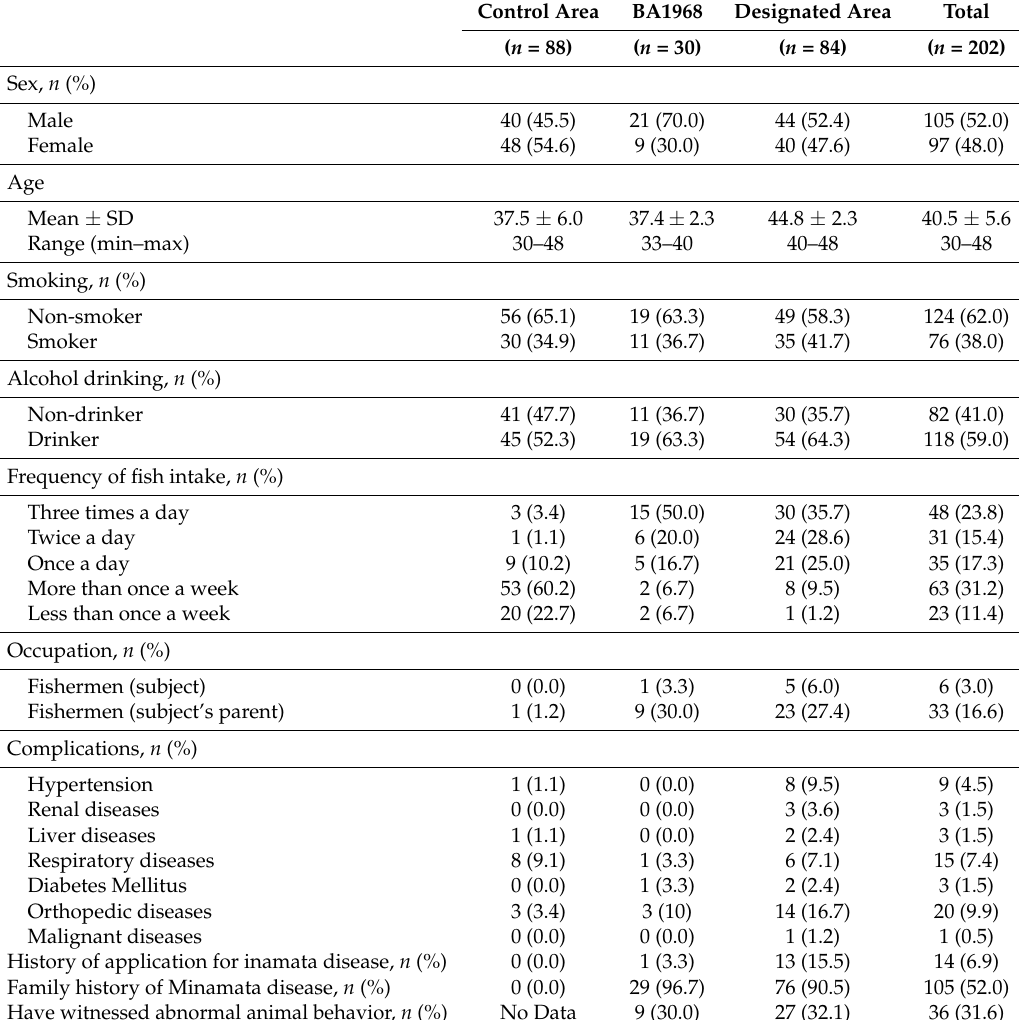
Table 15. Demographic characteristics of subjects in younger subjects ( n =